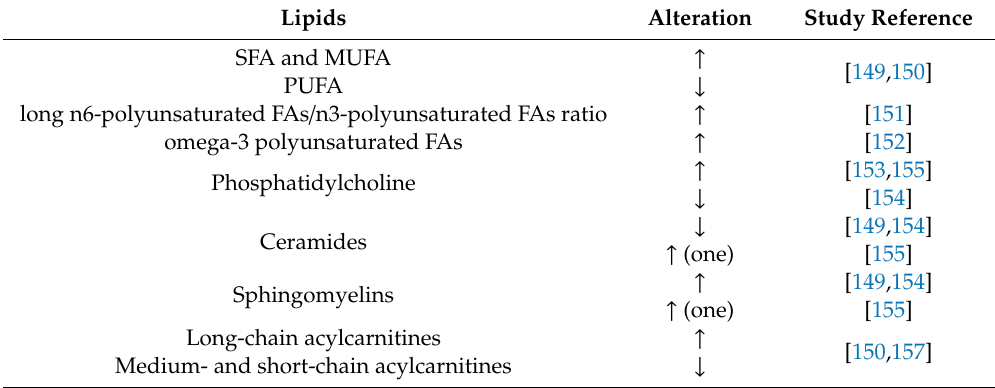
Table 1. Main lipid composition alterations in HCC revealed by Lipidomics studies. Saturated